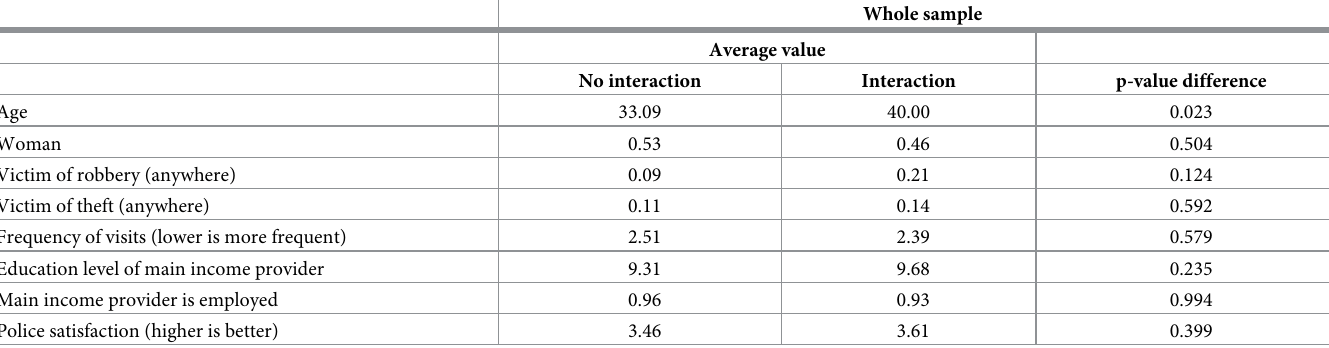
Table 4. Differences in observable characteristics according to interaction with the programme.